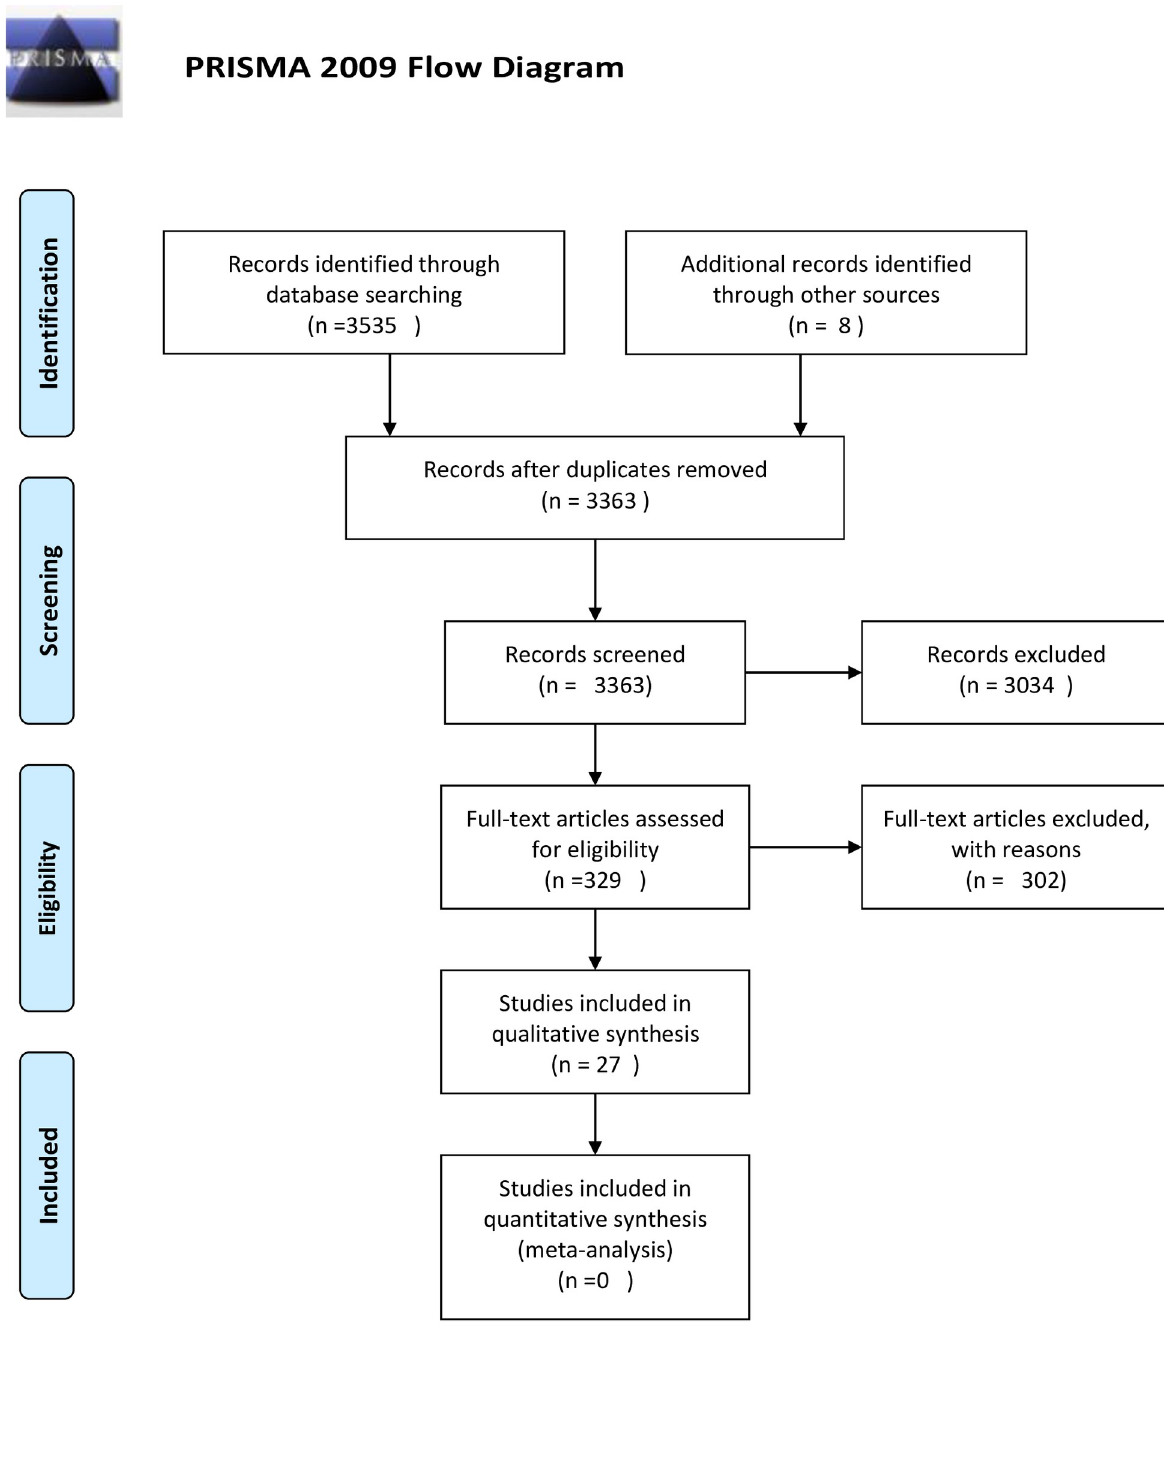
Fig 1. Flow diagram of the literature search according to the PRISMA statement.